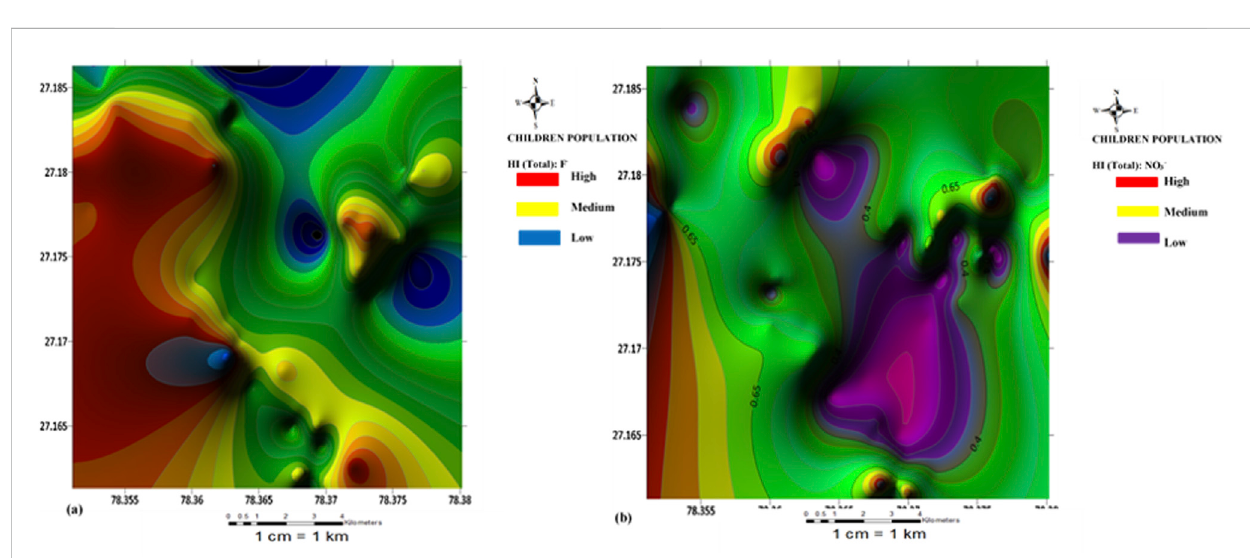
FIGURE 4 Spatial distribution health risk map of (A) fl uoride and (B) nitrate risk for children